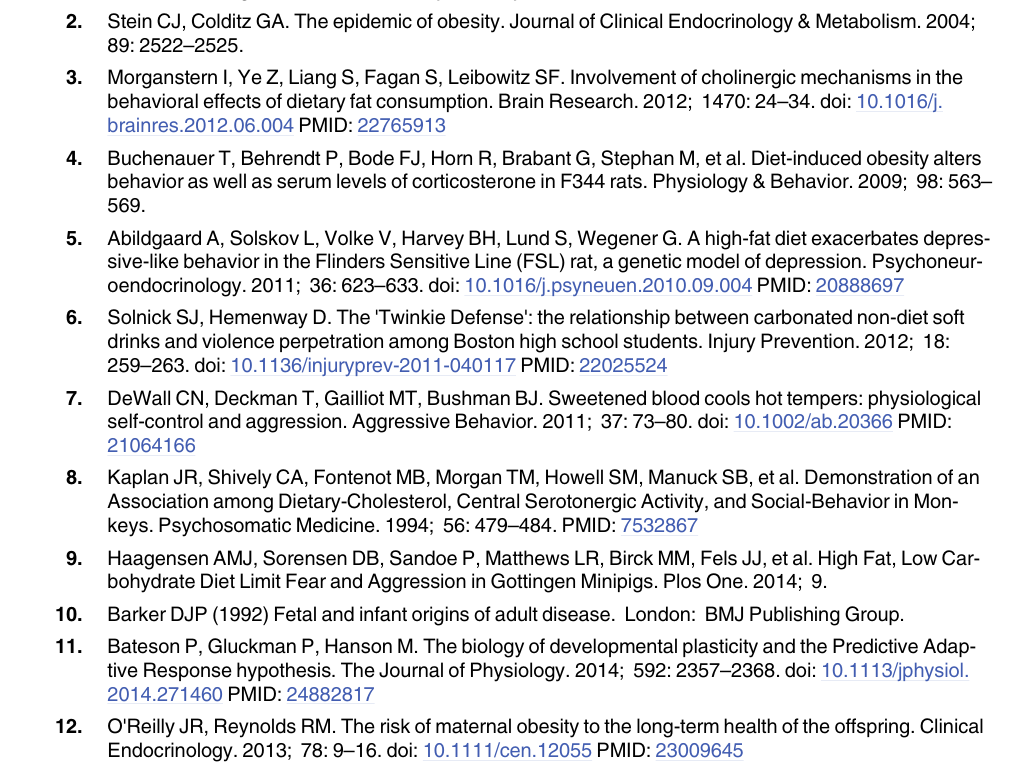
S2 Table. Behaviours of piglets during the combined open field and novel object test. (PDF) S3 Table. Behaviours of piglets during the combined open field and novel object